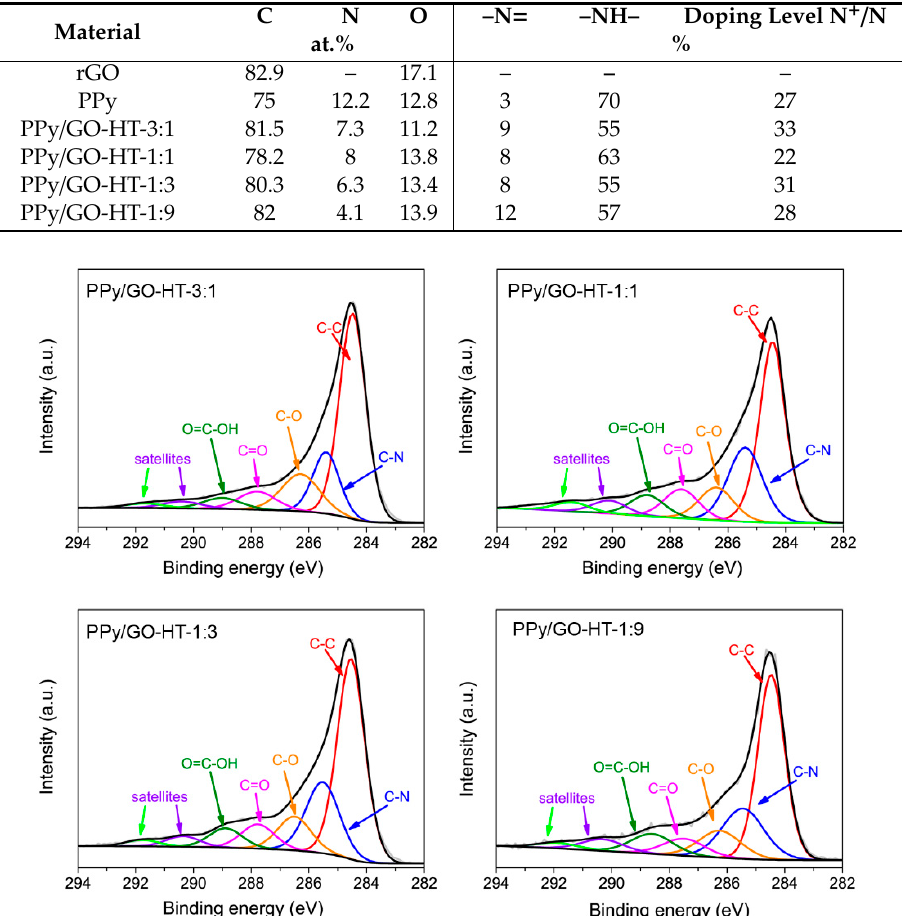
Figure 3. C1s high-resolution spectra of the PPy/GO-HT hybrids with different component mass ratios.